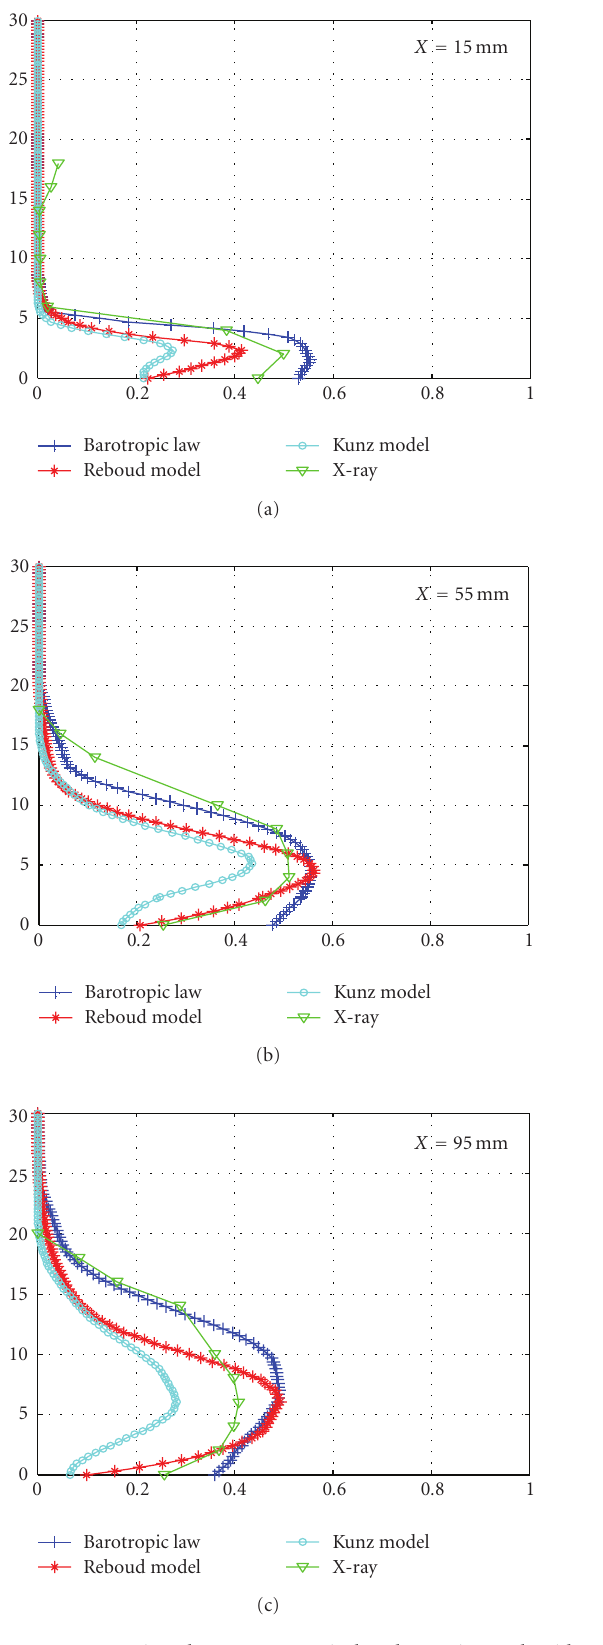
Figure 10: Comparison between numerical and experimental void fraction distributions ( L/c = 0 . 5, V ref =